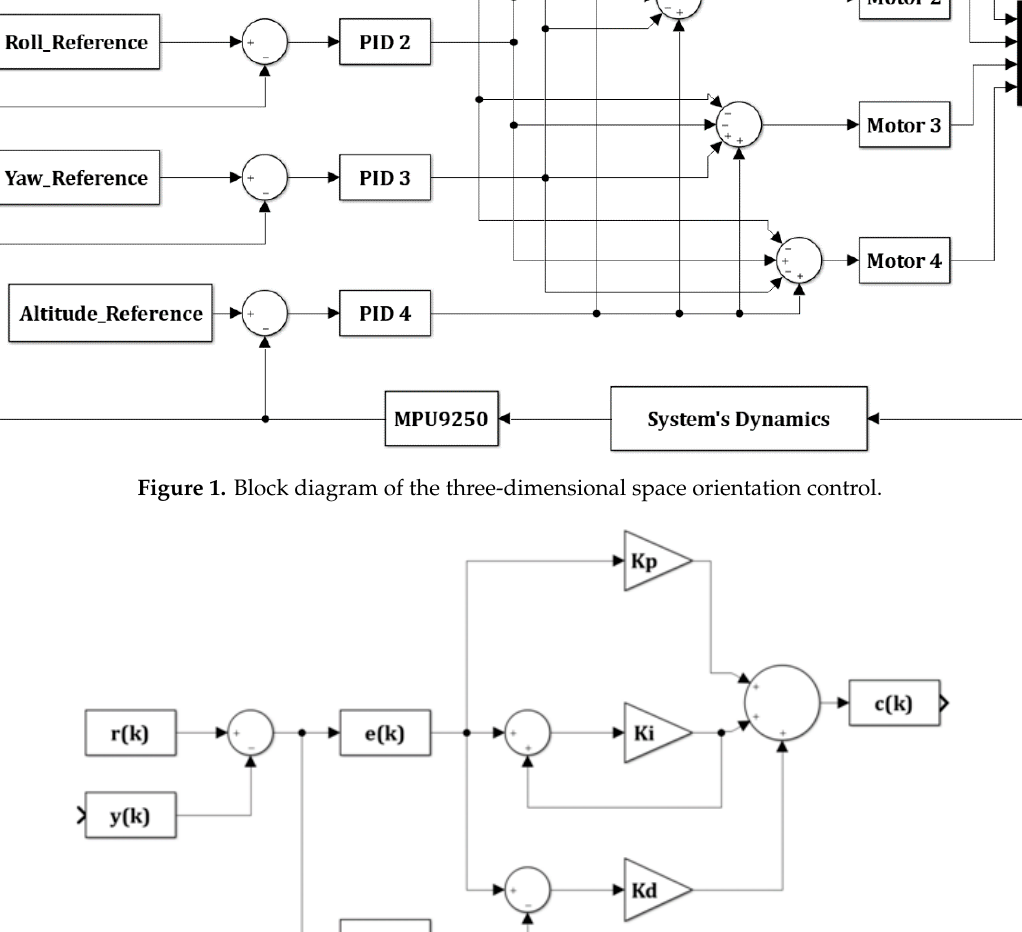
Figure 1. Block diagram of the three-dimensional space orientation control.